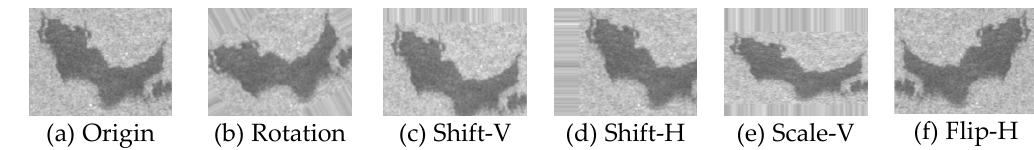
Figure 3. Examples of different data augmentation operations applied on a dark patch: ( a ) the original image; ( b ) the rotated image; ( c ) the vertically shifted image; ( d ) the horizontally shifted image; ( e ) the vertically scaled image; ( f ) the horizontally flipped image.